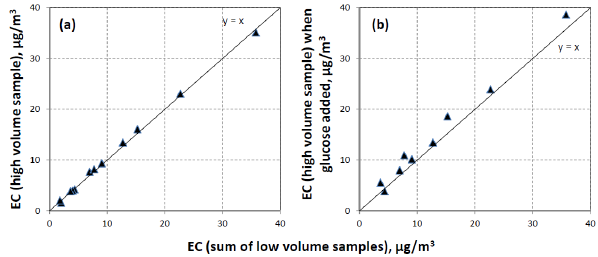
Figure 9. Comparison of EC and OC concentrations for different Fig. 9. Comparison of EC and OC concentrations for different lengths of sampling time. Error bars correspond to 3 20 % and 10 % uncertainty for EC and OC, respectively. 4 lengths of sampling time. Error bars correspond to 20 and 10% un- certainty for EC and OC,